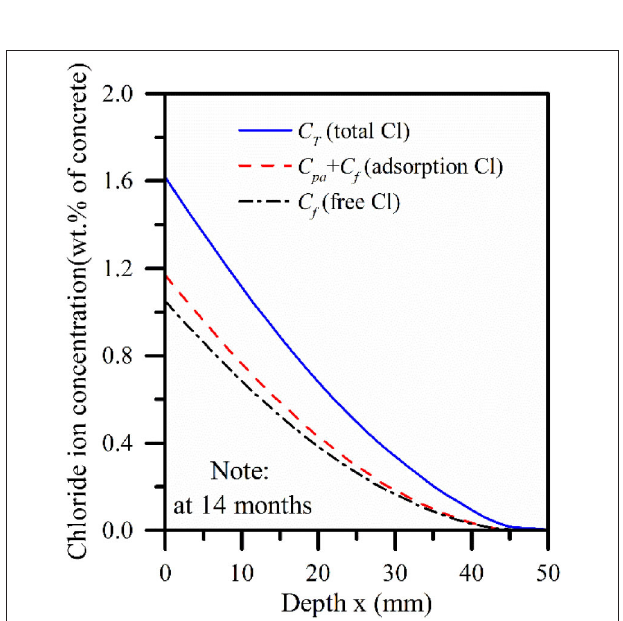
FIGURE 7 | The free chloride ion calculated by the model includes the physical adsorption and the total chloride concentration